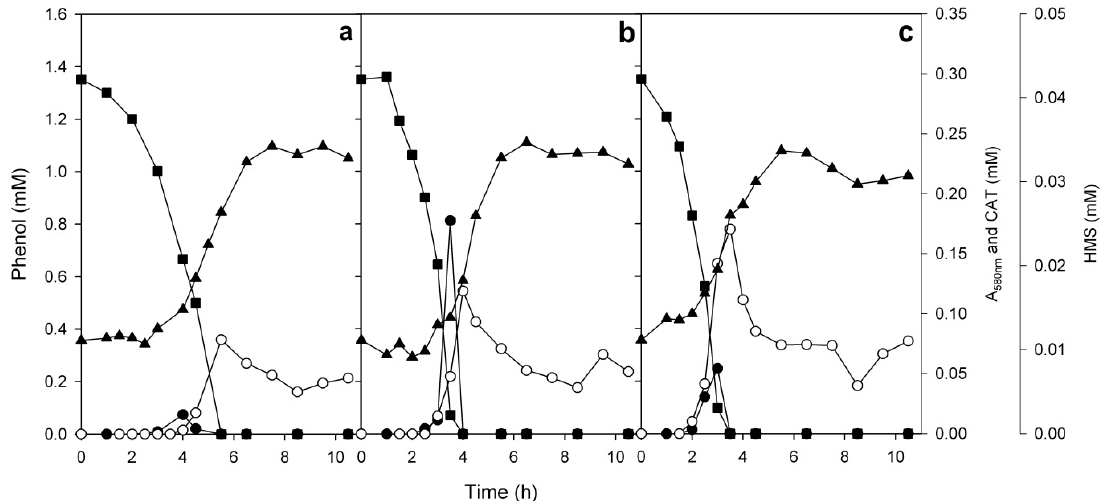
Figure 8. Growth of the mixed cultures of the strains ICP1 and ICTN13 on 1.3 mM phenol at 25 ( a ), 30 ( b ), and 35 ( c ) °C. Growth ( ▲ , measured as absorbance at 580 nm), degradation of phenol ( ■ ), accumulation of 2-hydroxymuconic semialdehyde (HMS, ○ ) and catechol (CAT, ● ). Concentrations of the substrates and intermediates are the averages of triplicate determinations; the combined standard uncertainties of the results were between 2.1% and 3.4%.